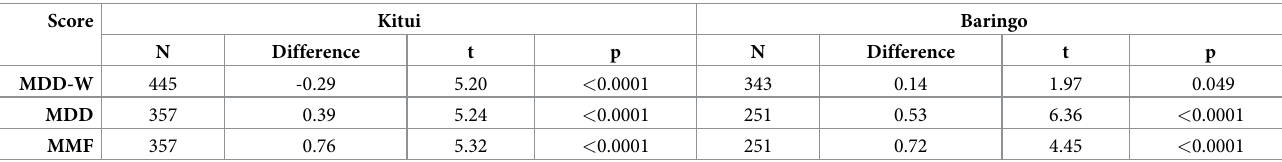
Table 3. Changes in nutrition score with CATI by county.